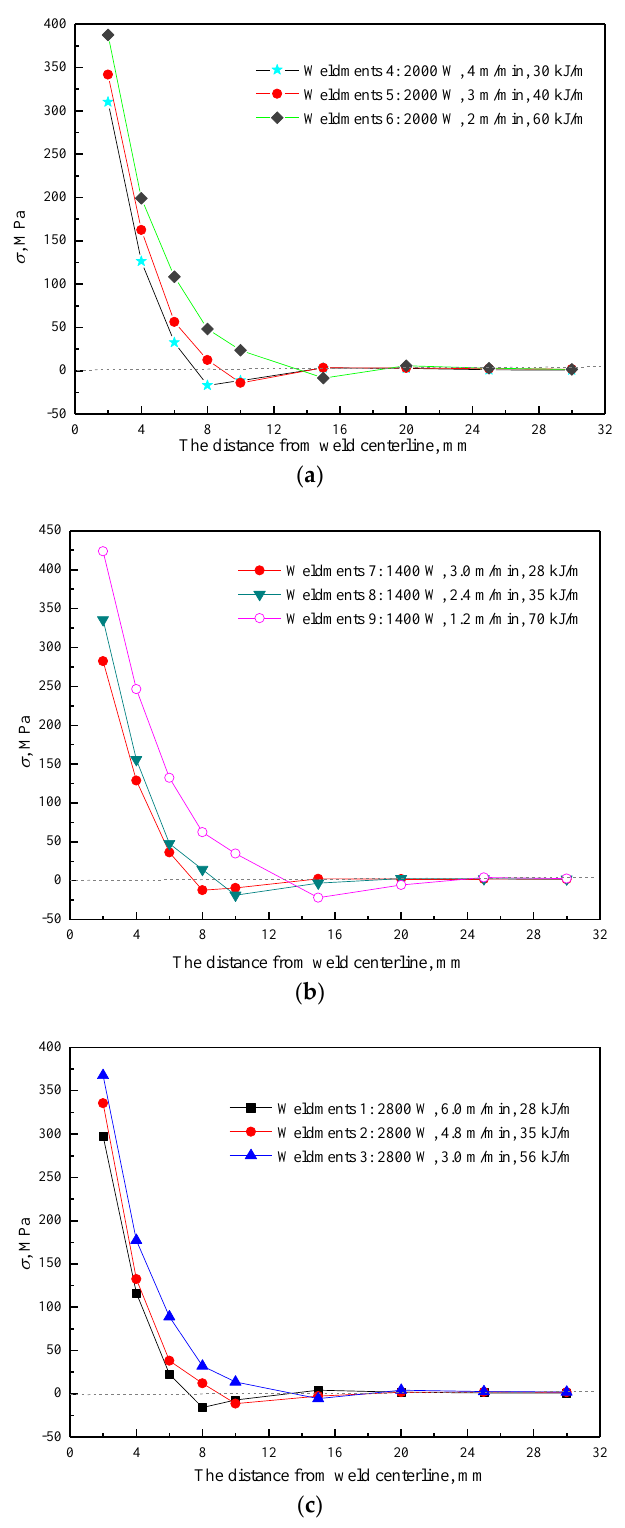
Figure 10. The longitudinal residual stress distribution with the same welding power: ( a ) 2000 W, ( b ) 1400 W, and ( c ) 2800 W.